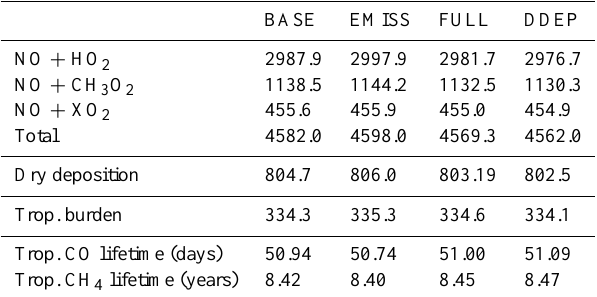
Table 5. The annual global chemical budget terms for tropospheric O 3 given in Tg O 3 yr − 1 for selected